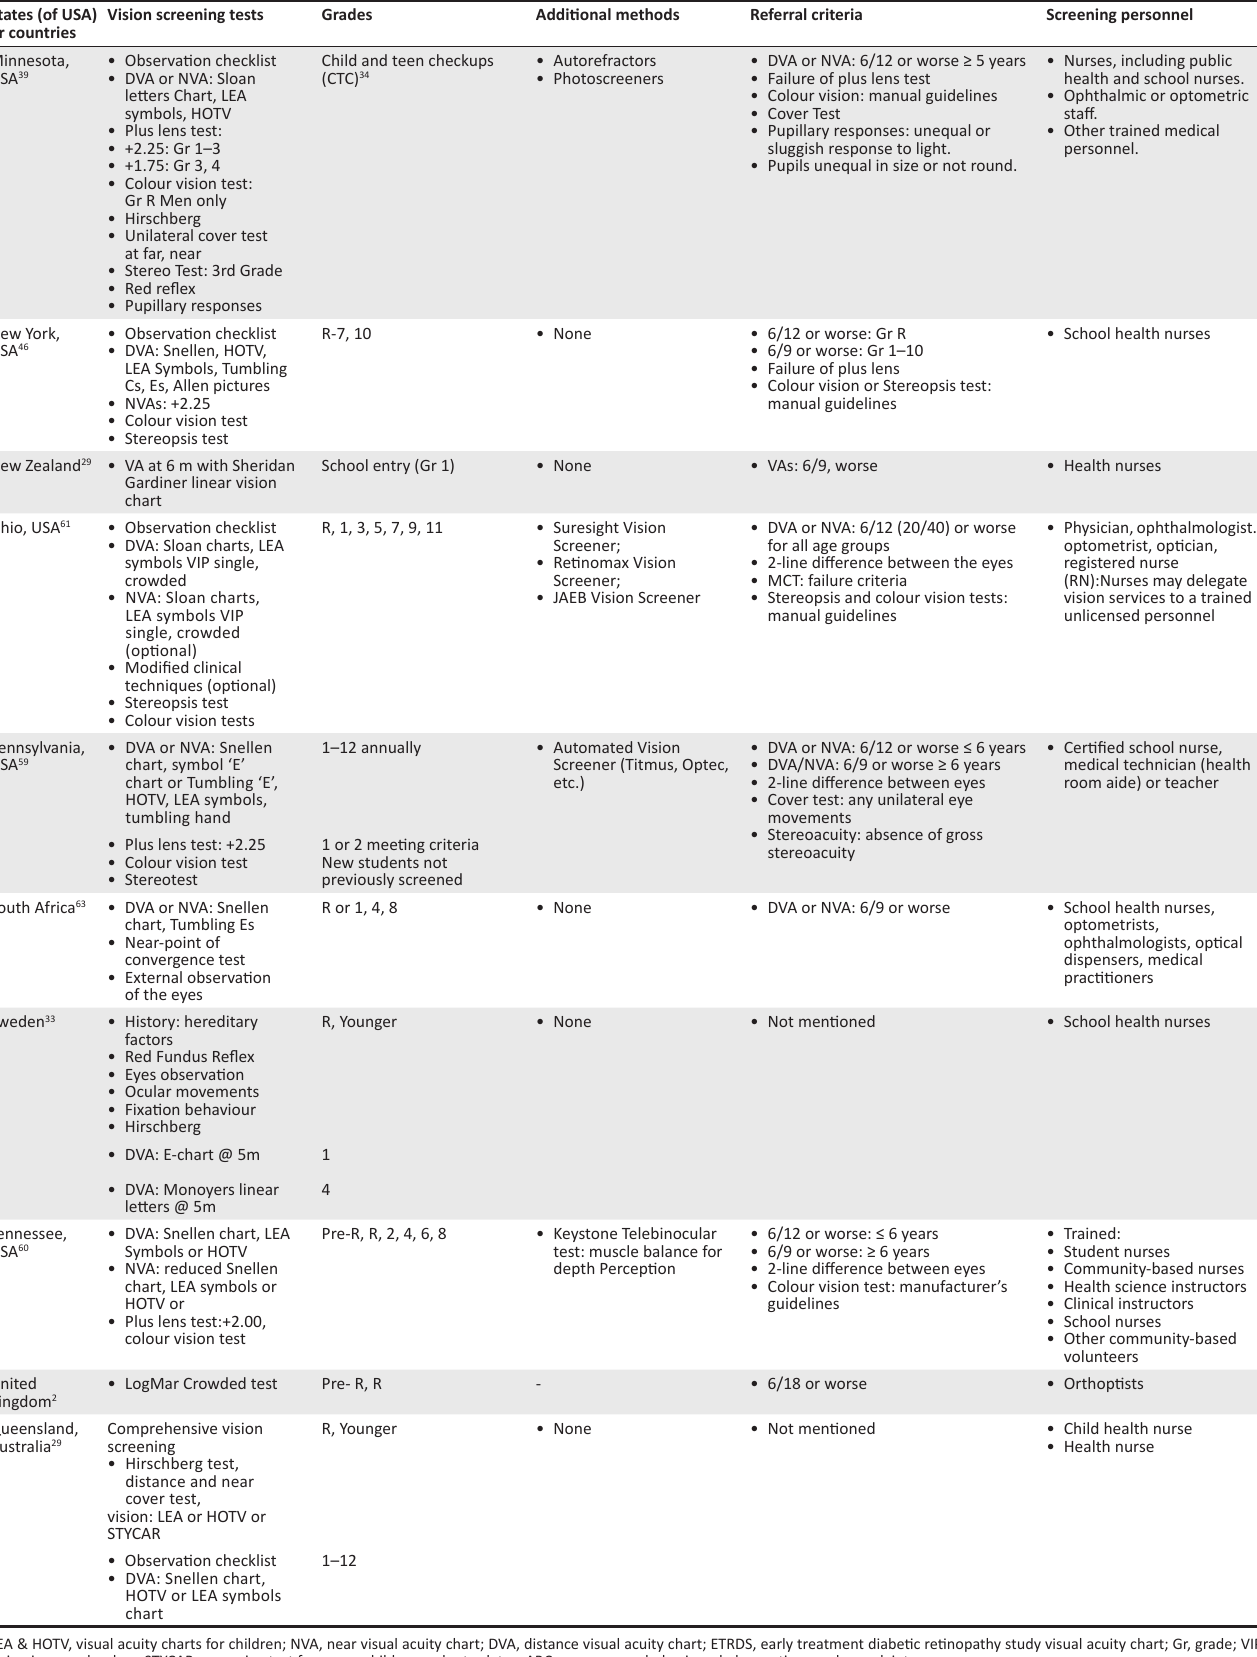
TABLE 1 (Continues...): International and national guidelines on children’s vision